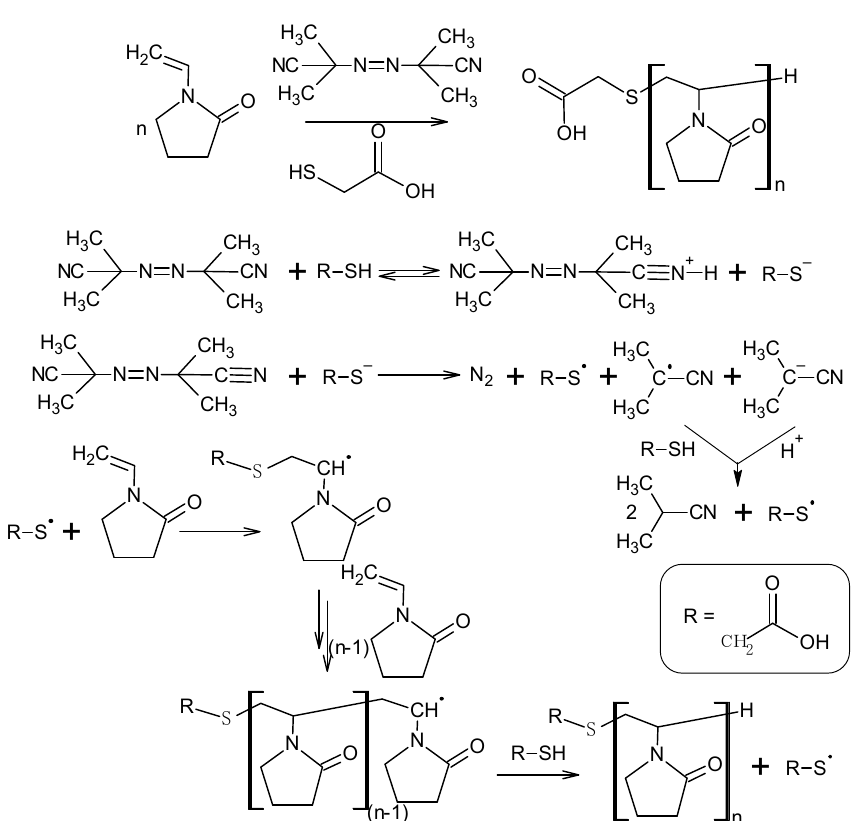
Figure 7. 13 C NMR spectrum (in D 2 O solution) of the telomer of N-vinyl-2-pyrrolidone obtained in the presence of sul- fanylethanoic